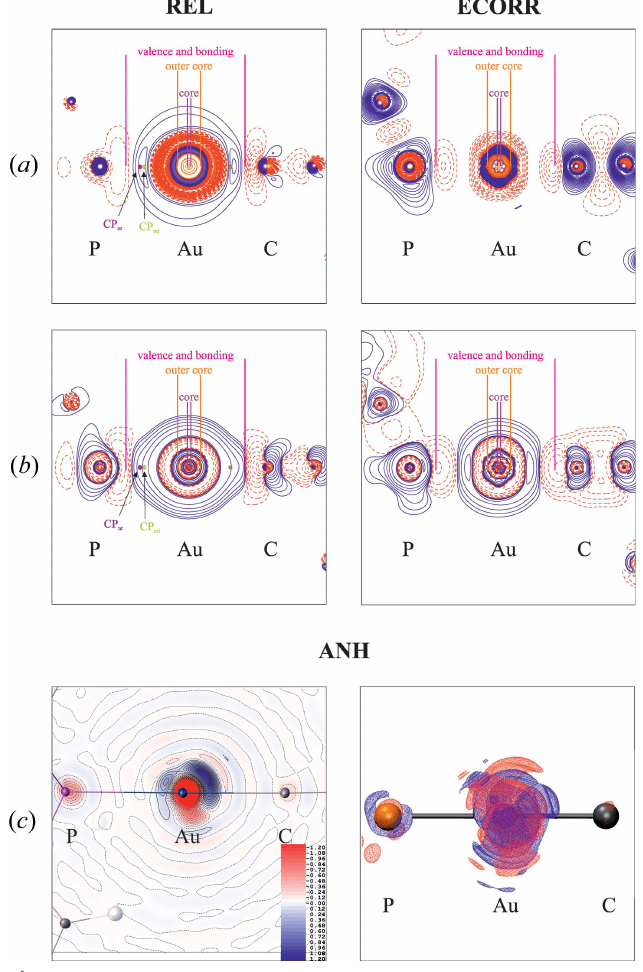
Figure 6 Difference maps for SP8 data of ( a ) static electron density (contour (cid:9) 0.01 e A (cid:2) 3 ) and ( b ) negative Laplacian (contour values are in geometric order, starting from (cid:9) 0.1 e A (cid:2) 5 with increments of 2 e A (cid:2) 5 ) exposing both the effects of relativity (REL) and electron correlation (ECORR). ( c ) 2D and 3D dynamic electron density in the plane of P— Au—C atoms exposing the effect of anharmonicity (ANH). Values of the positive and negative difference densities are denoted by blue solid and red dashed lines, respectively. Fig. 7, we present difference static electron density plots resulting from HARs performed only against SP8 data for clarity. They show the relativistic and electron correlation effects. The plots exhibit the distribution of the electron density in the core (from 0.0 to 0.005 A˚ ), outer core (from 0.1 to 0.3 A˚ ), valence (from 0.5 to 1.75 A˚ ) and bonding regions (from 1.2 to 1.5 A˚ ) of the above mentioned bonds.